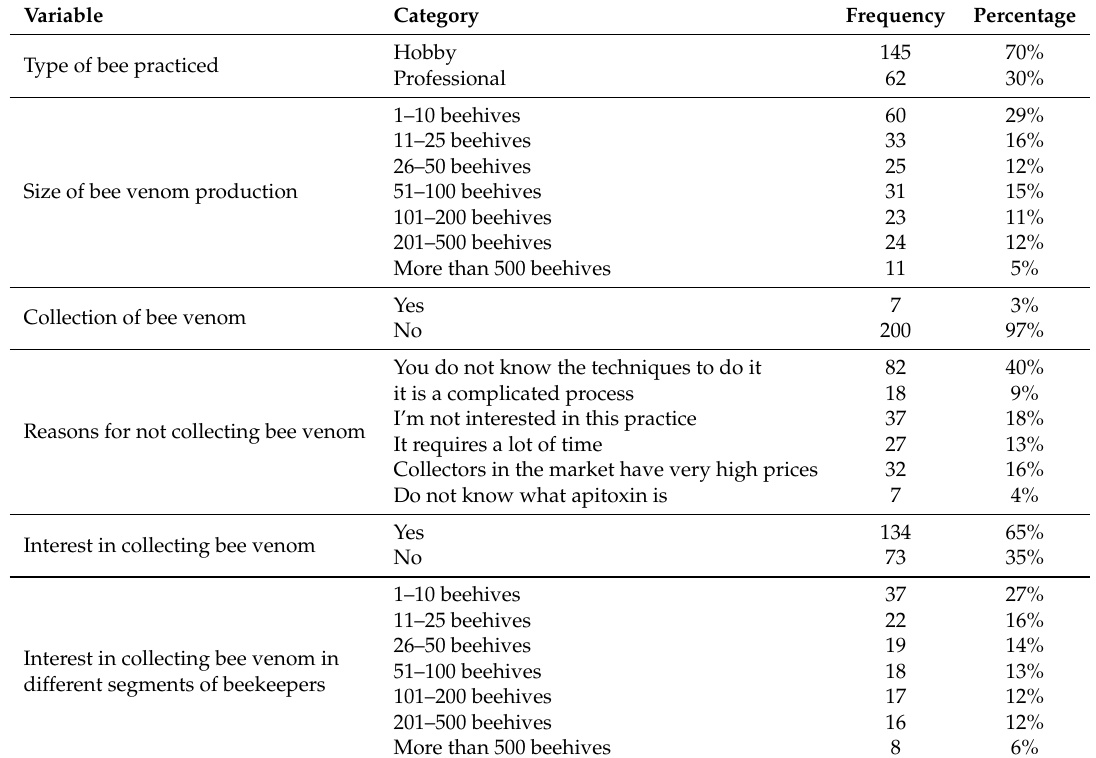
Figure 4. Percentages by Region of collected answers. Table 4. Data collected from the applied